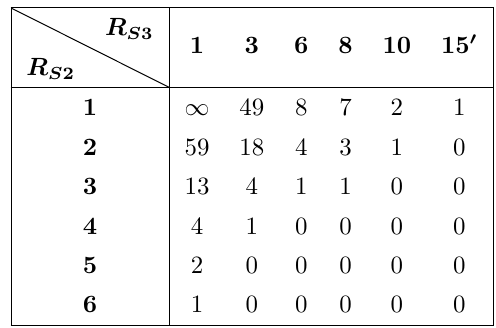
Table 3 . Maximal number of complex scalars with the common mass of 10 TeV for which the SM gauge couplings g and g remain perturbative up to 10 15 GeV . Y 3 2